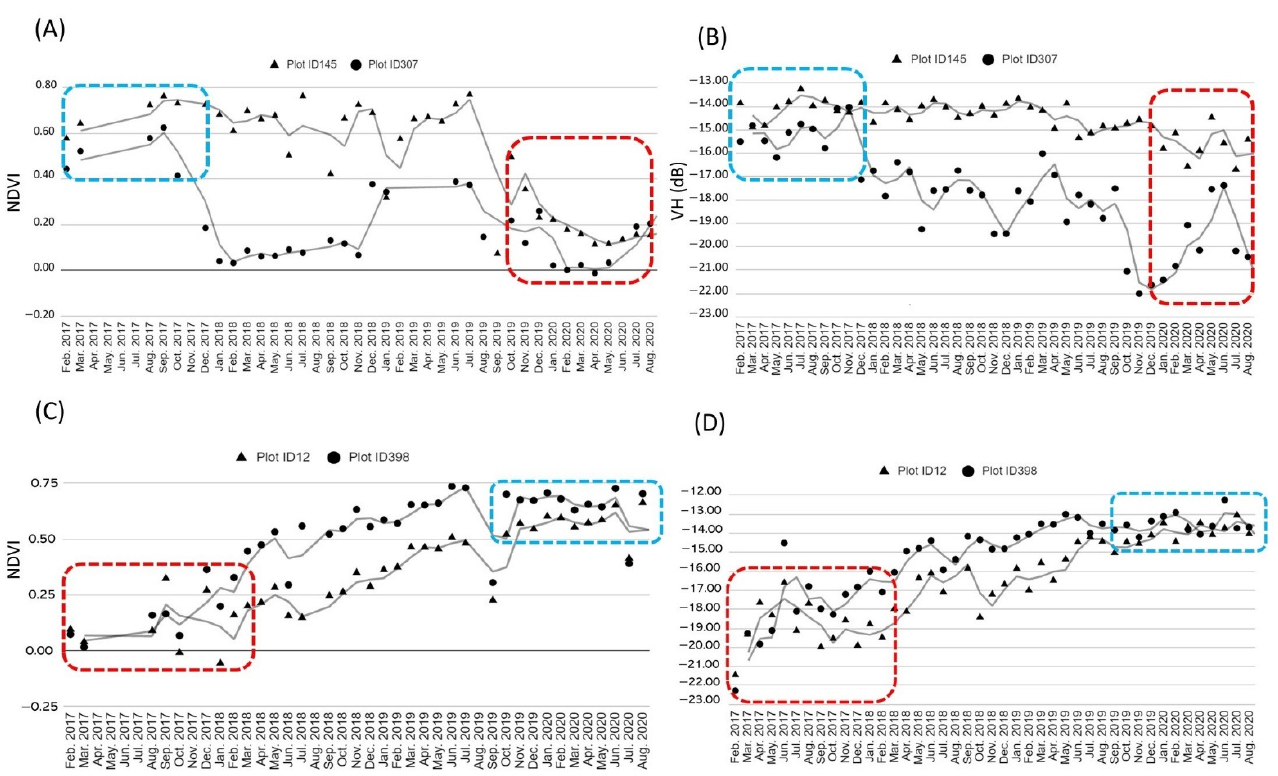
Figure 11. Example plots of mangrove stage changes. ( A ) Two sample plots of healthy mangrove changing to disturbance mangrove stages using NDVI, ( B ) Two sample plots of healthy mangrove changing to disturbance mangrove stages using VH from multiple-incidence angles, ( C ) Two sample plots of disturbance mangrove changing to recovery and on to healthy mangrove stages using NDVI, ( D ) Two sample plots of disturbance mangrove changing to recovery and on to healthy mangrove stages using VH from multiple-incidence angles, The red rectangles showed the lower period of mangrove forest covering, while the blues rectangle showed the high period of mangrove covering.